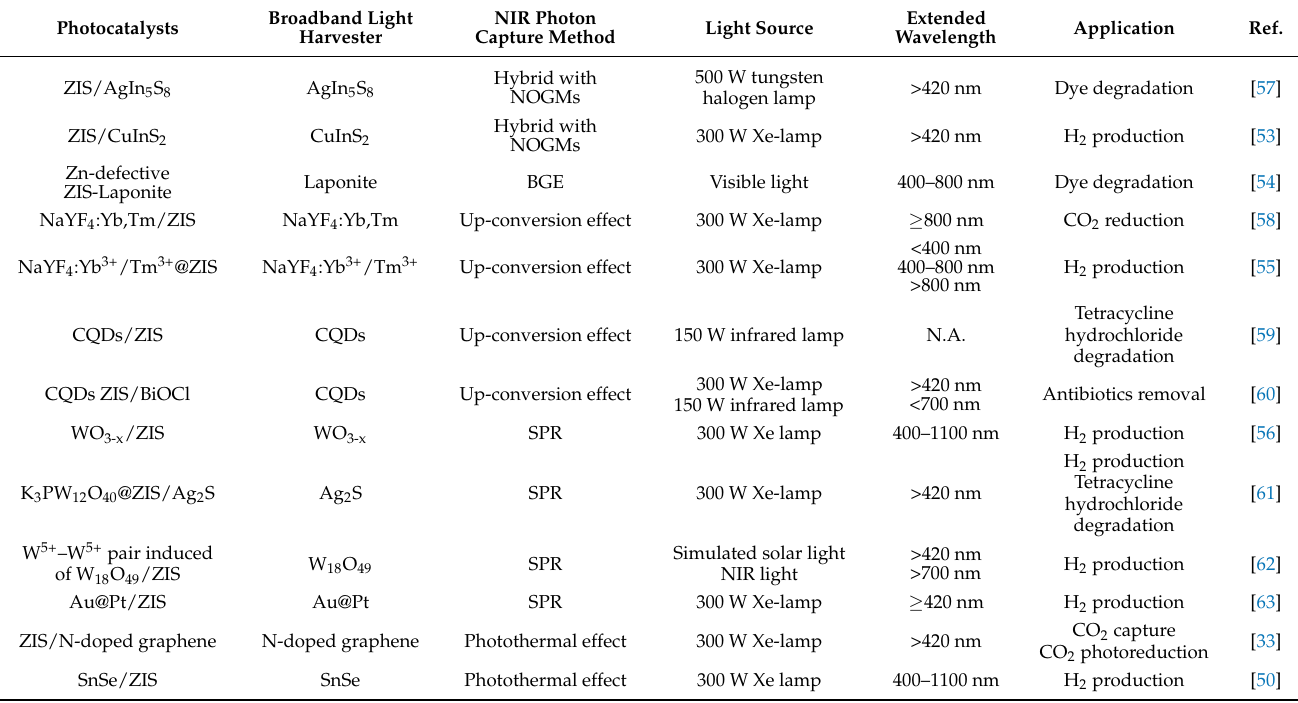
Table 1. Summary of NIR-driven ZnIn 2 S 4 -based NIR photocatalysts for various